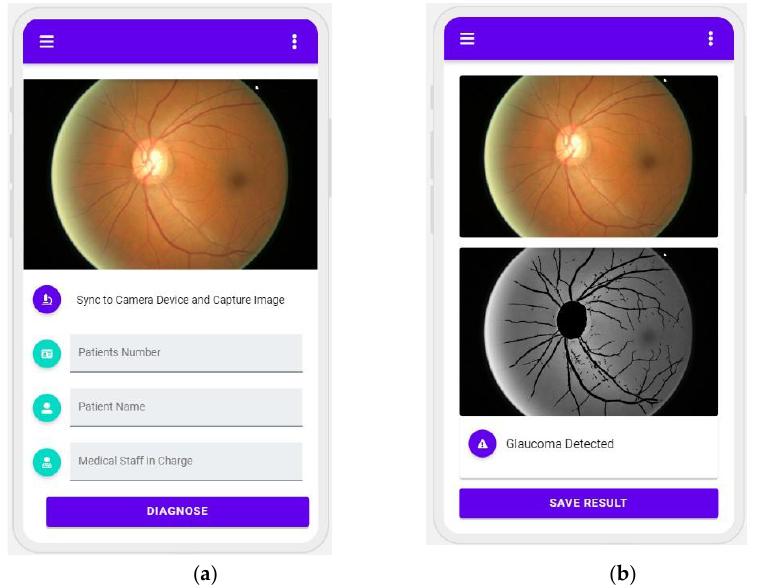
Figure 17. User interface (UI) design of a mobile application prototype for a user to ( a ) capture the eye image from the connected fundus camera and ( b ) get the diagnostic result.